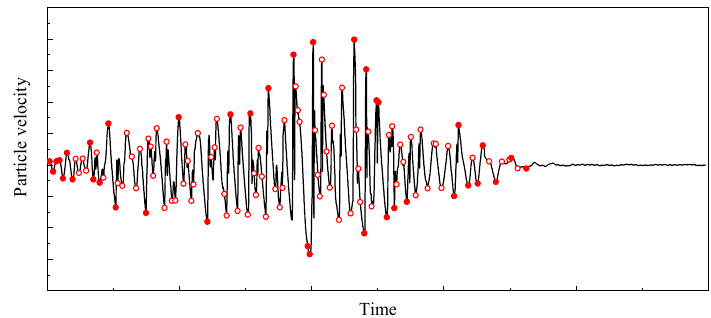
Figure 4. Typical waveform of open-pit deep-hole blasting.